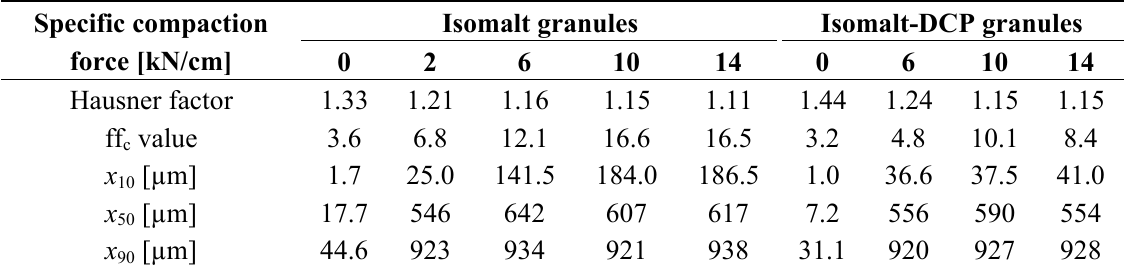
Table 1. Flow parameters and particle size percentiles (mean, coefficient of